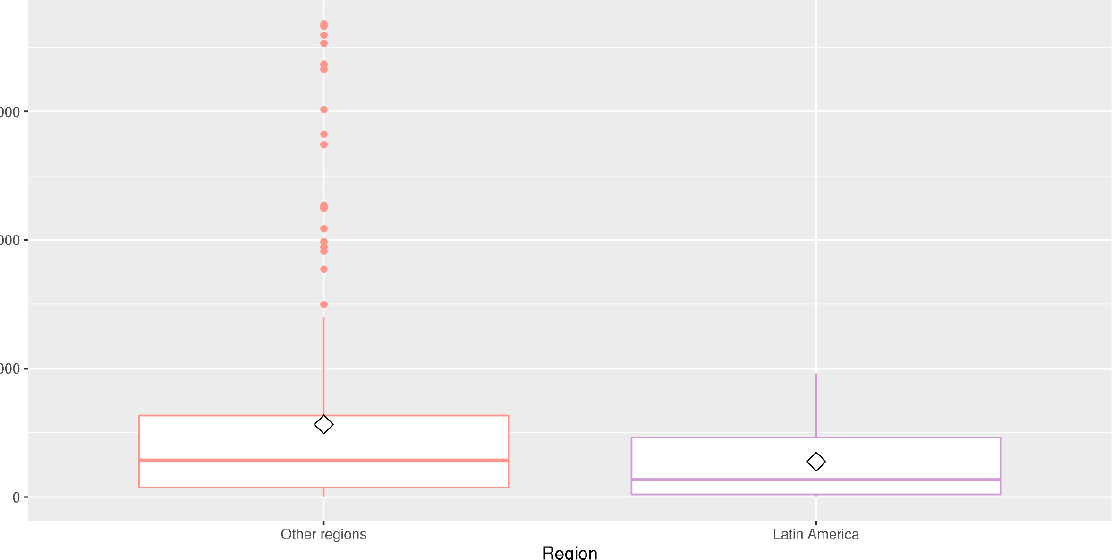
Figure 12. Global comparison of total citations between all regions. 3.7. Relationship between Journals and Institutions in LAC The rankings of the publishers, as academic institutions, provide insights into the quality of the integration of academic activities and scientific research. Table 4 provides a summary of the relationships between the dentistry journals and research institutions in LAC, alongside the Academic Ranking of Global Universities (ARWU) 2020 and QS 2020 metrics. The results show that Brazil’s top three dentistry journals in LAC are related to Brazilian universities ranked in the top 101–150 positions of the ARWU 2020 [34] and the top 116 of the QS 2020 ( QS World University Rankings 2020: Top Global Universities | Top Universities , n.d.) [35] indices.